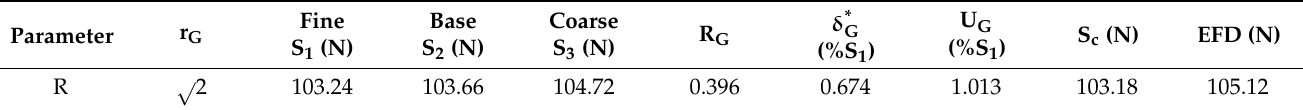
Table 1. Results of grid uncertainty